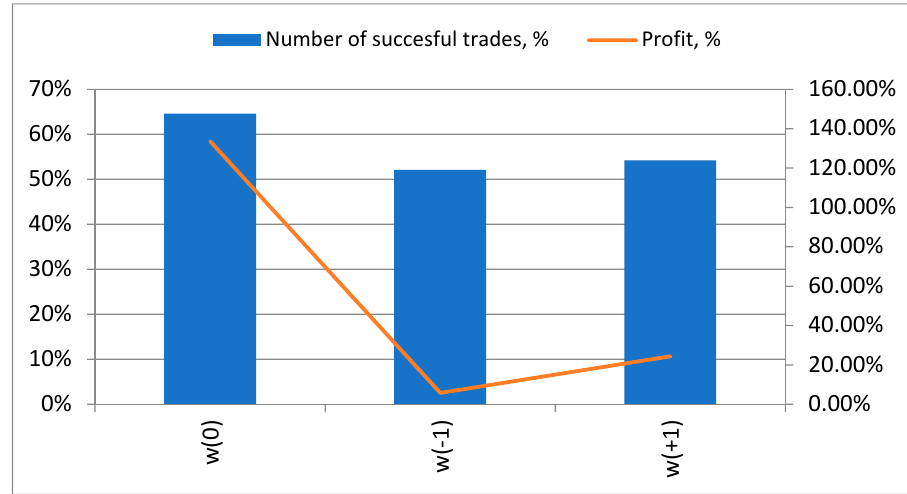
Figure 3. Trading simulation results of the expiration price effects: weekly data.